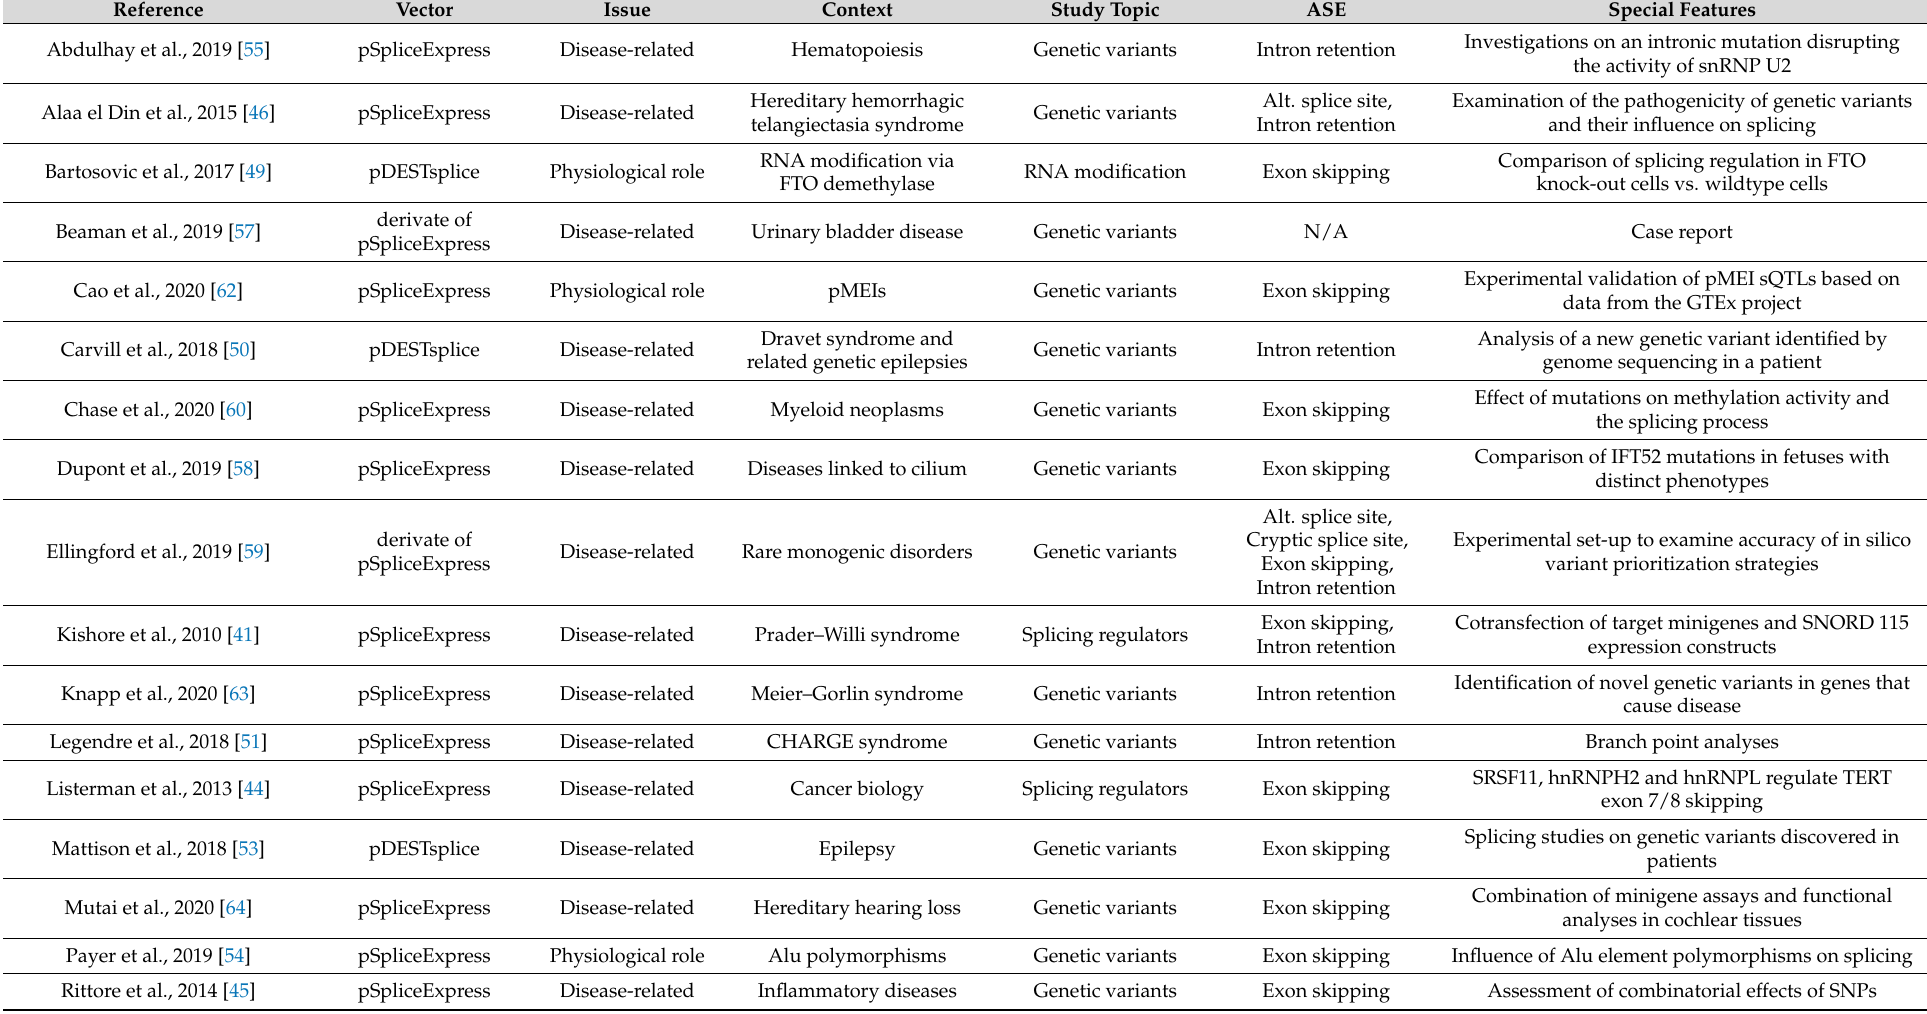
Table 1. Studies that explored alternative splicing by using pDESTsplice or